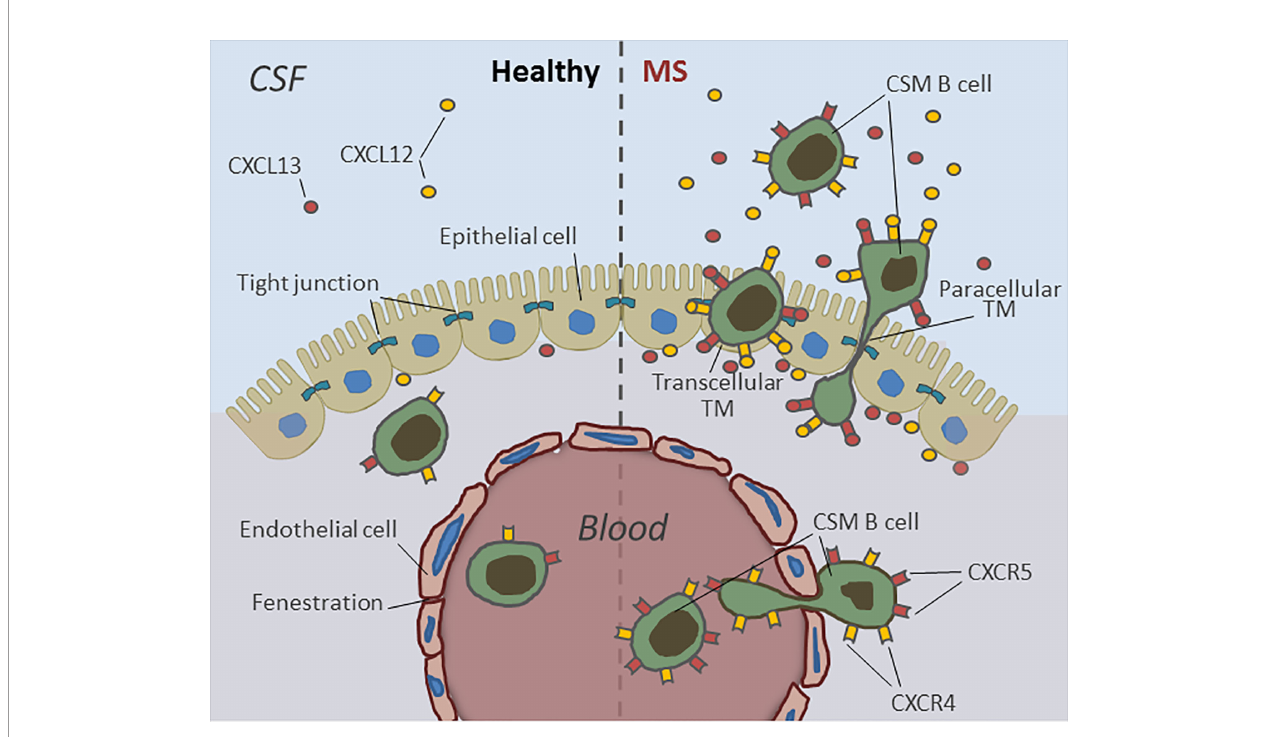
FIGURE 7 | Human B-cell migration through the blood – CSF-barrier in health and during active MS. B lymphocytes can easily pass the fenestrated blood vessels within the choroid plexus parenchyma but rarely enter the CSF due to the barrier properties of CP epithelial cells. During active MS the choroid plexus epithelium becomes permeable for pre-activated, CXCR4- and CXCR5 expressing antigen-experienced class-switched memory B cells (CSM). The transmigration of CSM B cells into the CSF is mediated by high intrathecal concentrations of B-cell speci fi c chemokines CXCL12- and -13 and occurs both by transcellular and paracellular